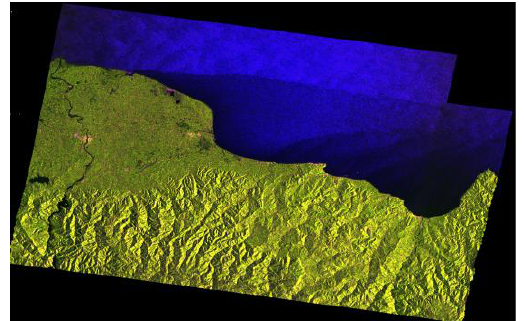
Figure 6. Filtered C11 and C22 backscatter response in RGB combination (red:C11, green: C22, blue: C11/C22).